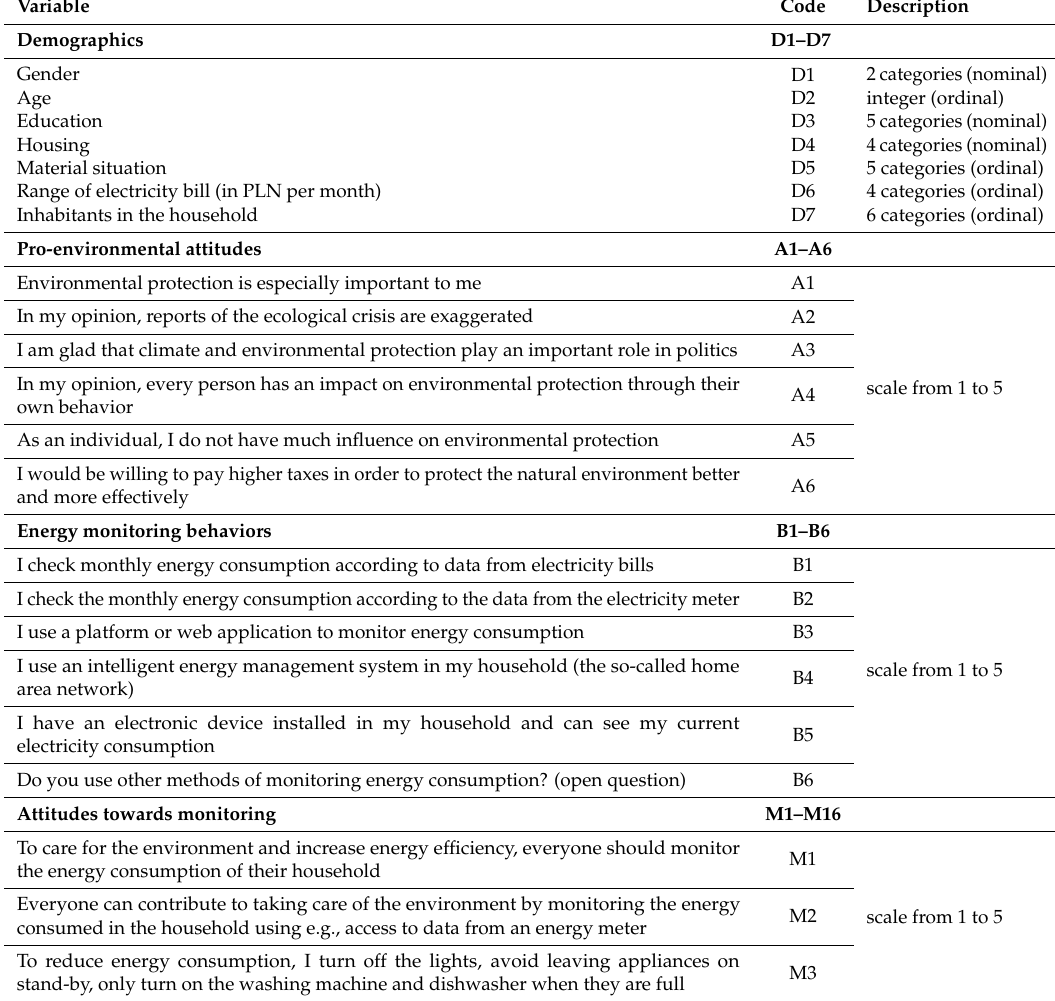
Table A1. Definitions of the variables, coding, and